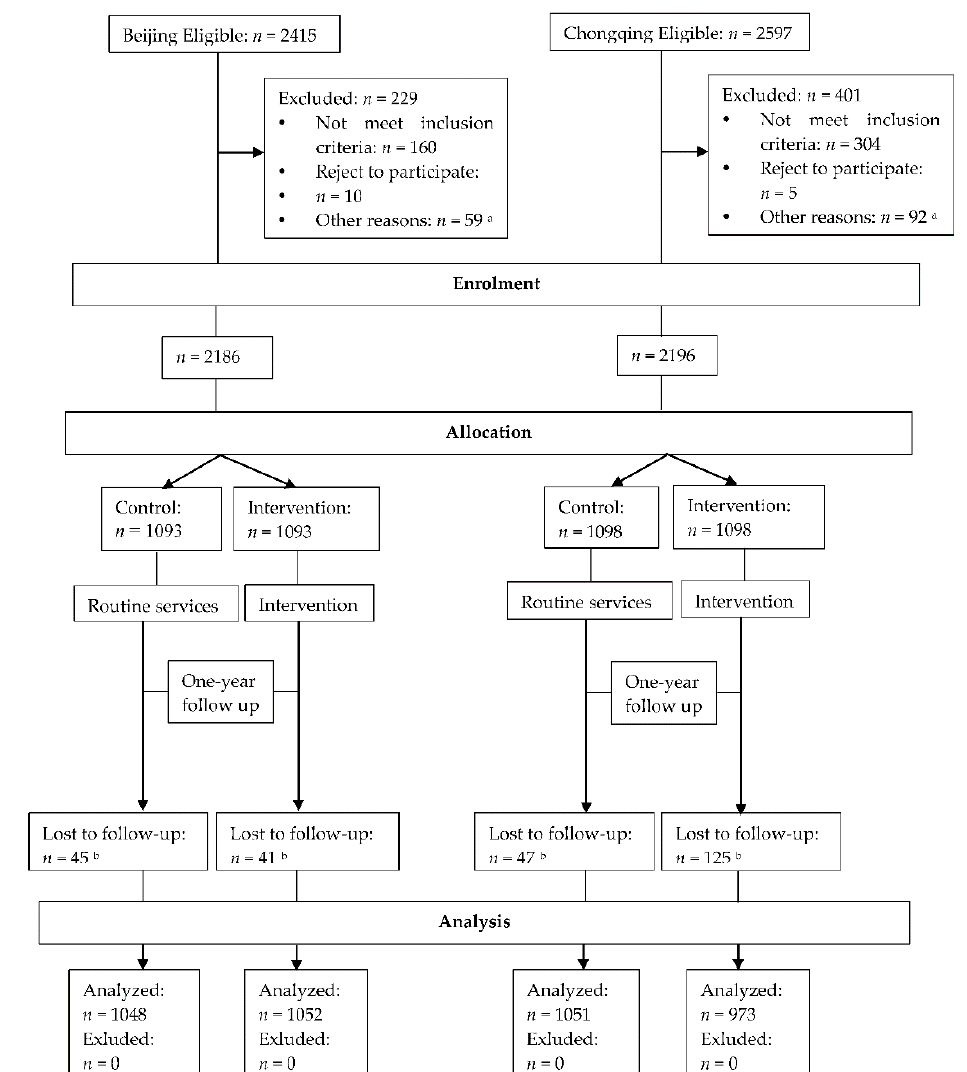
Figure 2. Flow of participants through each study stage in the two cities. a The primary reason was that the participants were absent in these sites. b Lost to follow-up was calculated as the total number allocated to the control and intervention groups, respectively, minus the number that received a follow-up at one year.